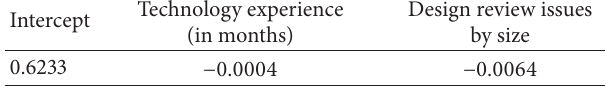
Figure 1: Residual plot.